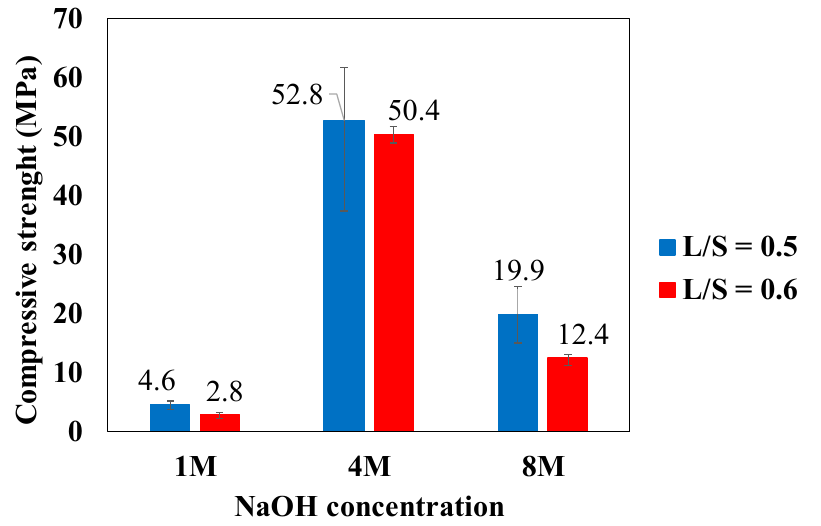
Figure 7. Compressive strength ( σ s ) results of the different AAC formulations obtained depending on the L/S ratios (0.5 and 0.6) and the NaOH concentration.